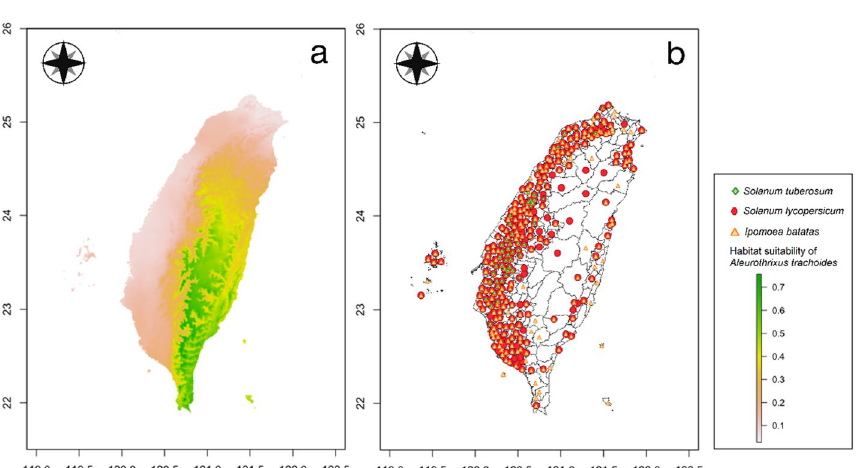
Figure 5. Comparison of potential distribution area of Aleurothrixus trachoides and cultivation area of Solanum tuberosum , S. lycopersicum , and Ipomoea batatas in Taiwan: ( a ) potential distribution ( b ) cultivation areas. Maps were created using R version 4.04 (https:// www.r- proje ct. org/) and QGIS version 3.12.1 (www. qgis.